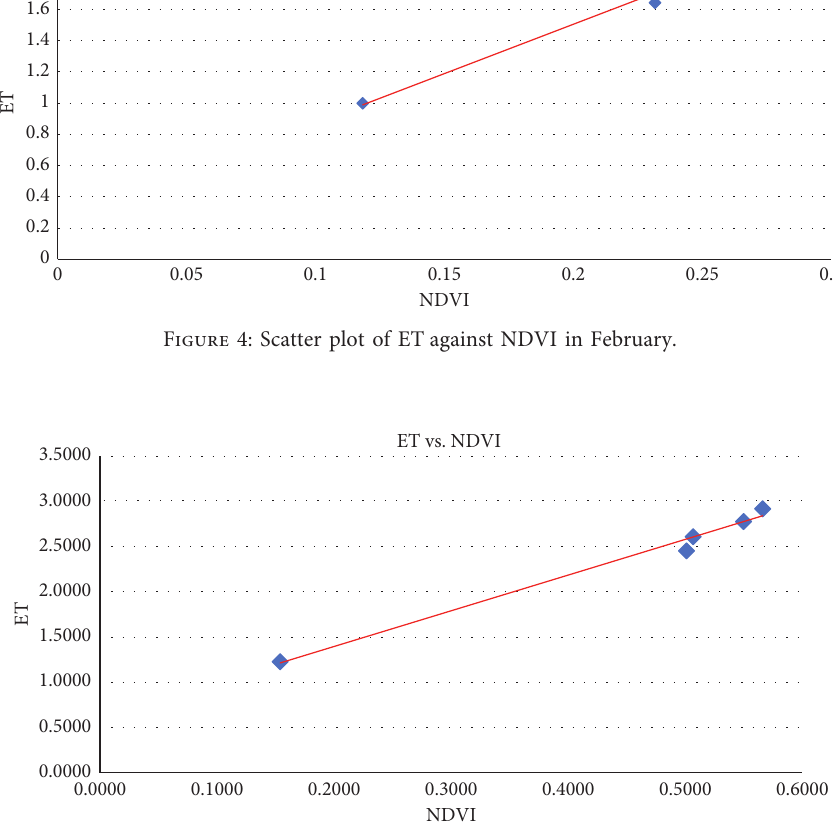
Figure 5: Scatter plot of ET against NDVI in